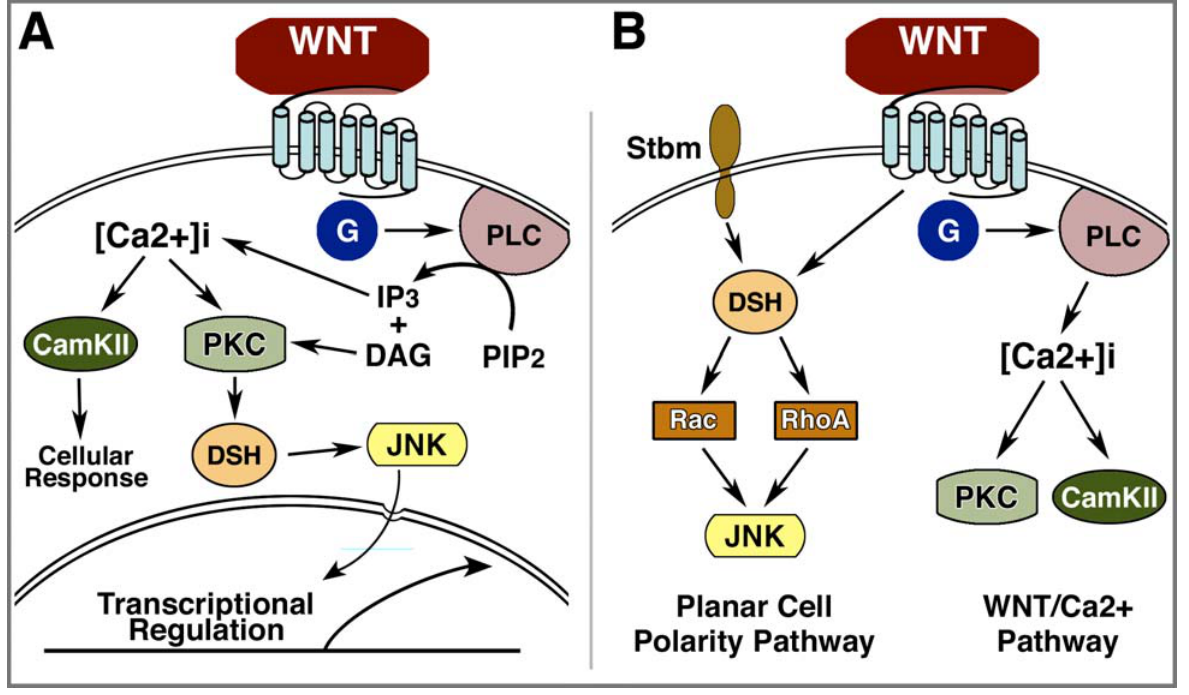
FIGURE 2. Noncanonical WNT signal transduction pathway(s). (A) Depiction of a single noncanonical Wnt pathway involving G-proteins, phospholipase C (PLC), protein kinase C (PKC), c-jun kinase (JNK), Ca2+/calmodulin-dependent protein kinase II (CaMKII), and Dsh. Key features include the hydrolysis of phosphatidylinositol bisphosphate (PIP2) by PLC to produce diacylglycerol (DAG) and inositol triphosphate (IP3), which in turn promotes intracellular Ca2+ release. Activated PKC regulates Dsh protein, which subsequently stimulates JNK activity. (B) Noncanonical Wnt signaling is often portrayed as two distinct pathways, which are the planar cell polarity (PCP) and Wnt/Ca2+ pathways. Molecules that may distinguish the PCP pathway are the transmembrane protein strabismus (stbm), which is a putative regulator of Dsh; and the Rho family GTPases, Rac and RhoA, which stimulate JNK activity. Note the involvement of Dsh in both canonical and noncanonical Wnt pathways, which may be due to altering its activities by differential phosphorylation[46]. Please refer to the text for references that provide a more in depth description of these signal transduction